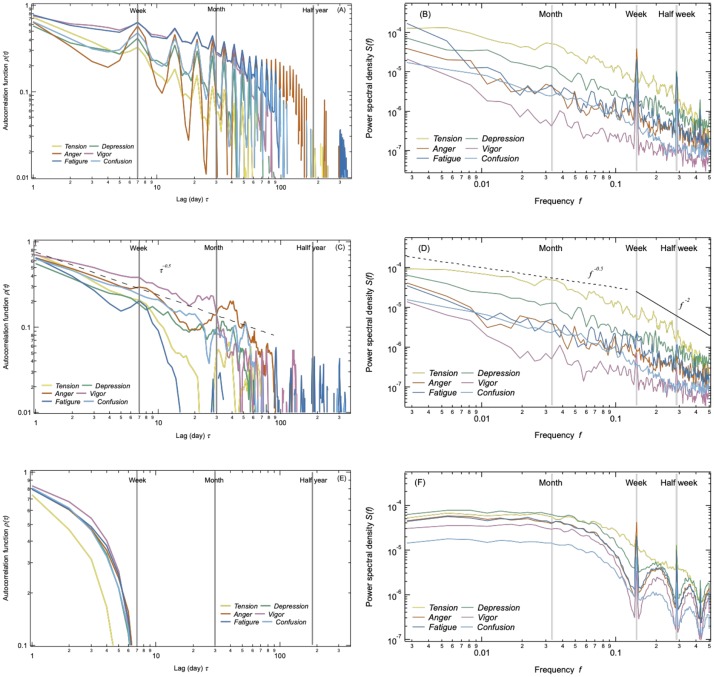
Autocorrelation functions ρk(τ) and power spectral density Sk(f) of collective emotion.ρk(τ) and Sk(f) are calculated for (A)(B) Raw emotional dynamics which shows periodic cycles, (C)(D) Emotional dynamics without periodic cycles which shows long-term memory, (E)(F) Weekly randomized dynamics which diminished correlations larger than weekly scale.